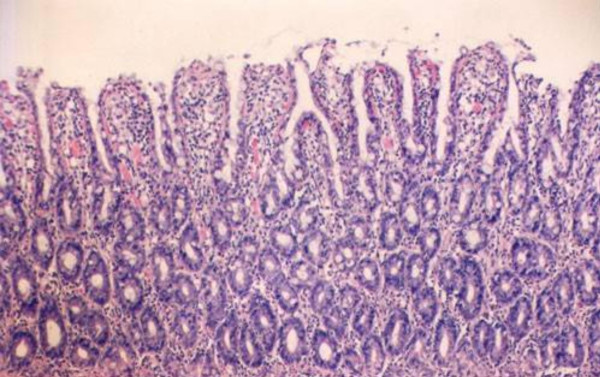
Villus necrosis involving >distal one-half villus involvement in group V rats (Grade III) (HE, ×100).